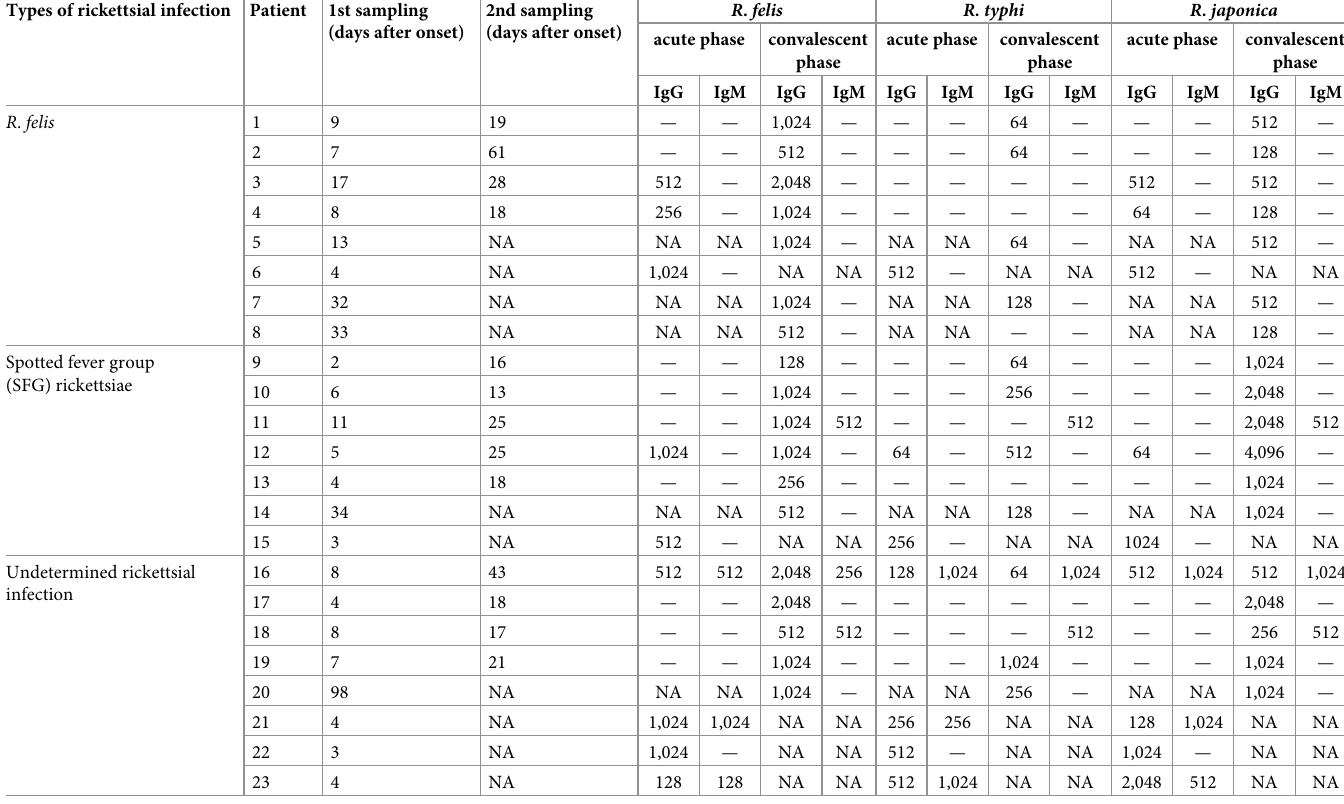
Table 1. Antibodies against Rickettsia spp. in patients with suspected rickettsioses but tested negative for scrub typhus, Q fever, or murine typhus. Types of rickettsial infection Patient 1st sampling 2nd sampling (days after onset) (days after